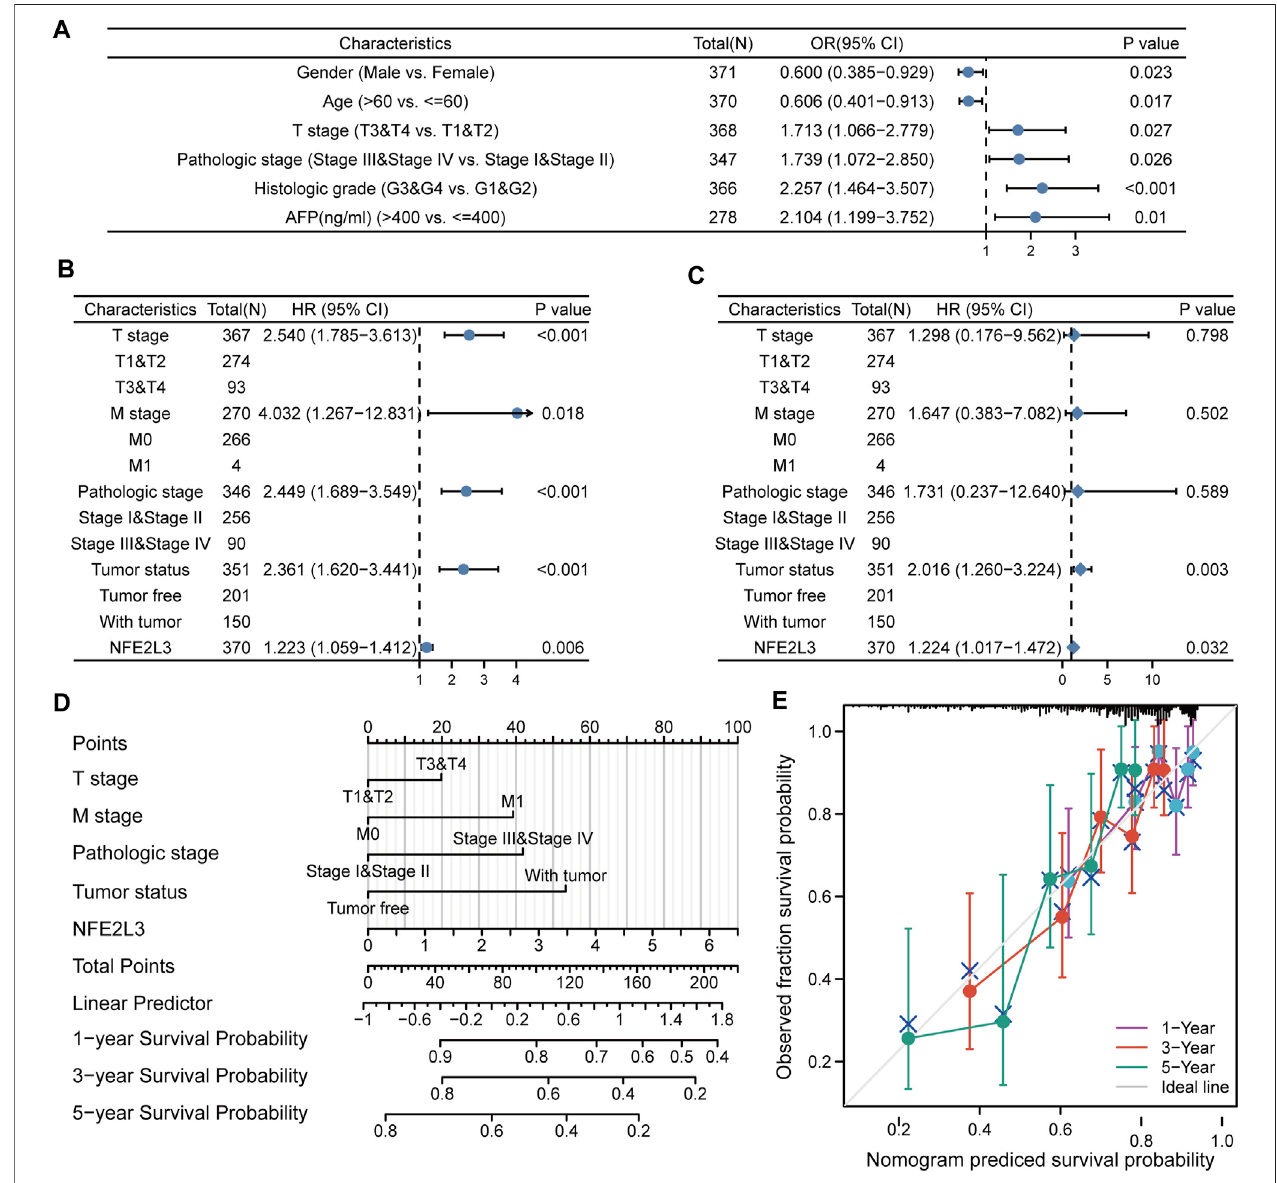
FIGURE 12 | Relationship between the expression level of NFE2L3 and clinical characteristics in LIHC. (A) Logistic regression analysis of expression level and clinicalcharacteristicsofNFE2L3inLIHC. (B,C) ForestplotsoftheunivariateandmultivariateCoxinLIHC. (D) AnomogrambasedonTstage,Mstage,pathologicstage, tumor status, and NFE2L3 for predicting the OS of patients with LIHC. (E) The calibration plot indicated the calibration of the nomogram model.